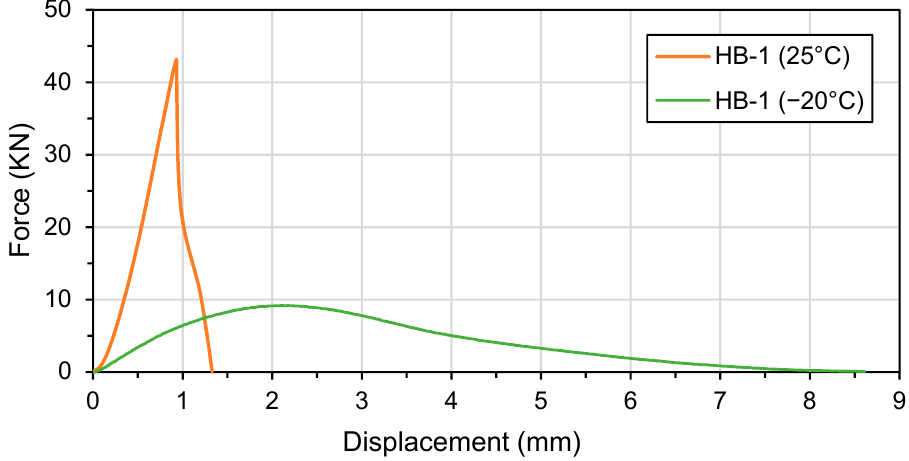
Figure 15. IDT results example: force recorded as a function of displacement for HB-1 specimens at 25 °C and − 20 °C.